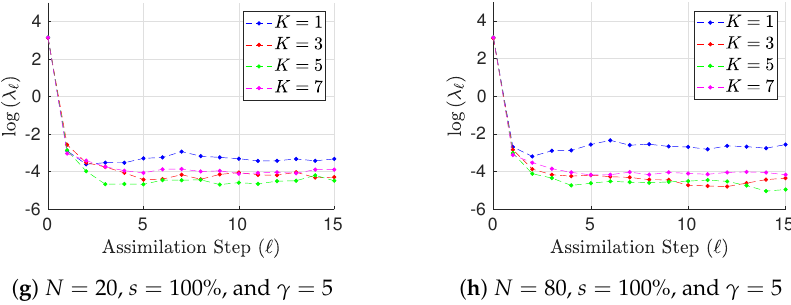
Figure 1. Experimental results with the Lorenz-96 model (29). The time evolution of mean analysis errors and their standard deviation across the 10 different experimental configurations are reported for γ ∈ { 1, 3, 5 } , and δ t = 16.